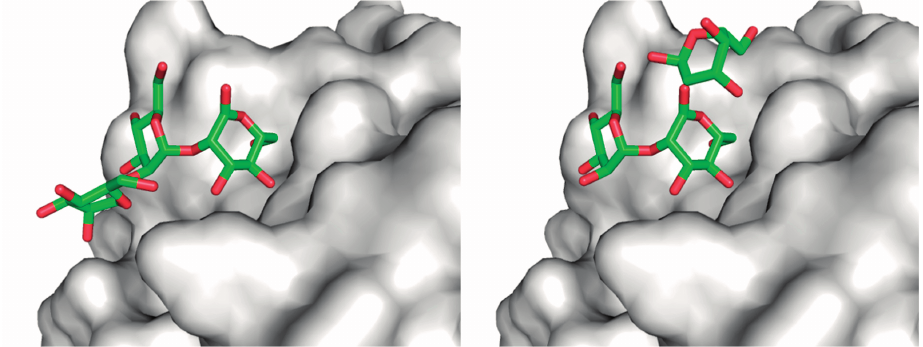
Figure 5. Two alternative modes for interactions of α 1,2-linked mannotriose with ERGIC-53 CRD . The terminal nonreducing ( left ) and reducing ( right ) mannose residues were modeled, as previously described